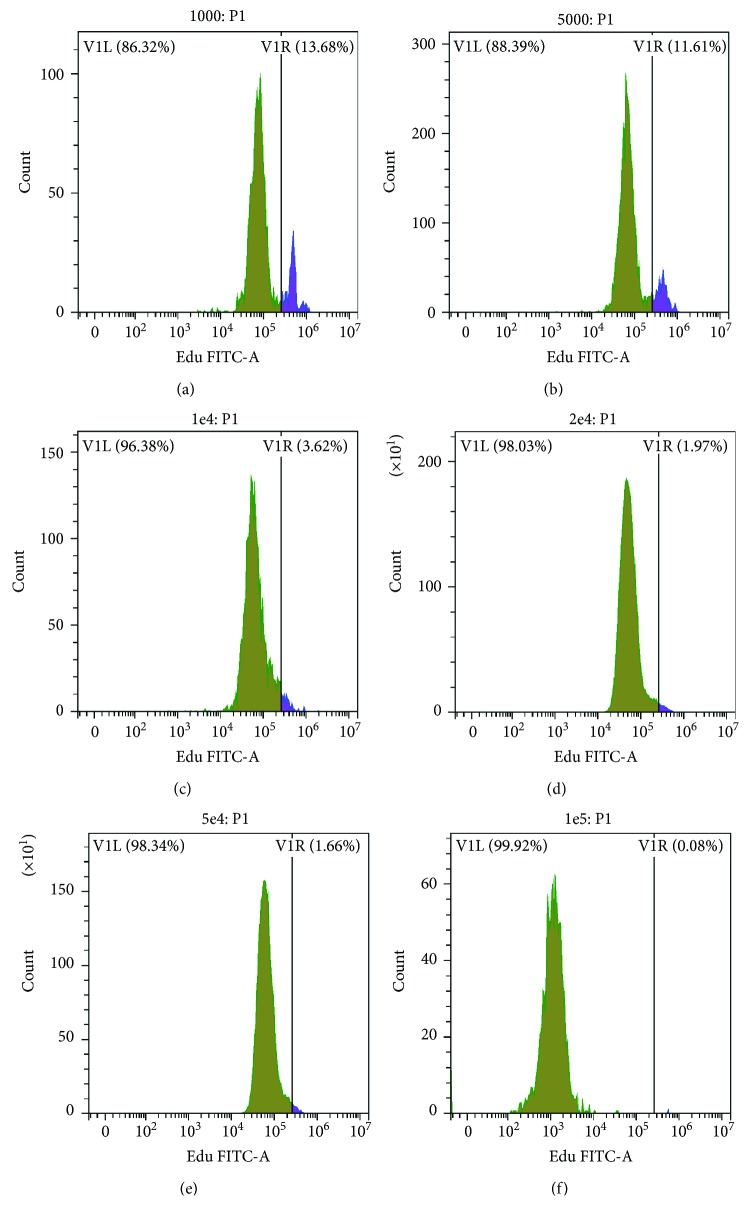
The percentage of proliferative cells within tSKP spheres, represented by EdU-positive cells. (a) 1 × 103 cells/mL: 13.68%. (b) 5 × 103 cells/mL: 11.61%. (c) 1 × 104 cells/mL: 3.62%. (d) 2 × 104 cells/ml: 1.97%. (e) 5 × 104 cells/mL: 1.66%. (f) 1 × 105 cells/mL: 0.08%.